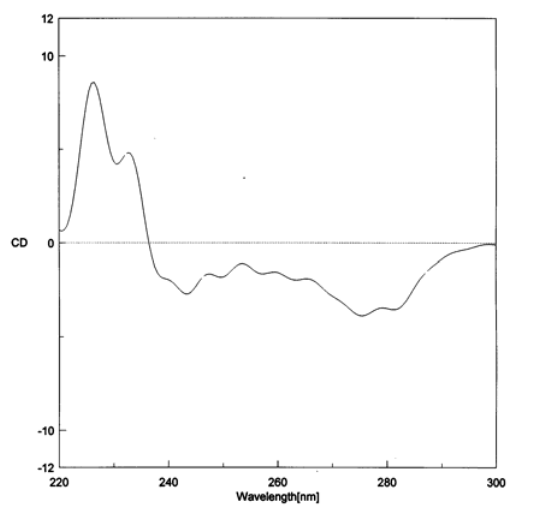
Figure 3. CD of data compound